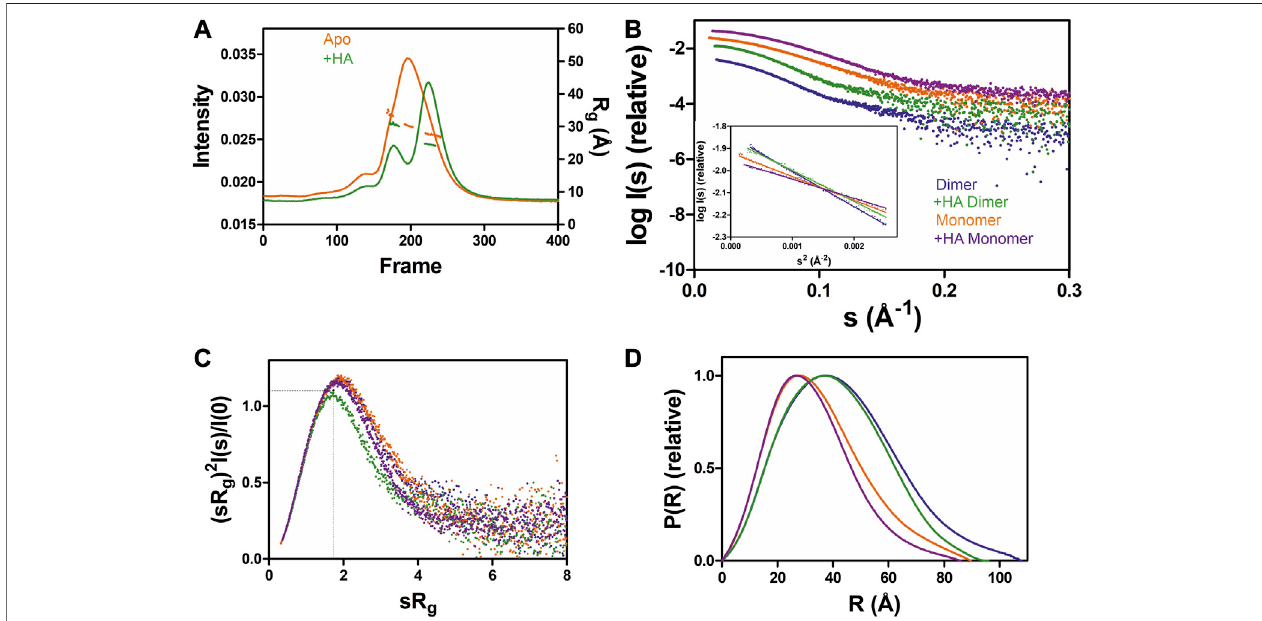
FIGURE 3 | SAXS analysis of GDAP1 Δ 319-358 in the absence and presence of HA. (A) SEC-SAXS elution pro fi les and R g plot of SAXS frames for dimer and monomer peaks of the protein. (B) Experimental scattering data (log(I s ) vs. s) and Guinier analysis (inset). (C) R g normalized Kratky plots, the dashed lines representing the maximum value of a standard globular protein. (D) Distance distributions p(r) plots of ligand-free GDAP1 dimer (blue) and monomer (orange), ligand-bound GDAP1 dimer (green) and monomer